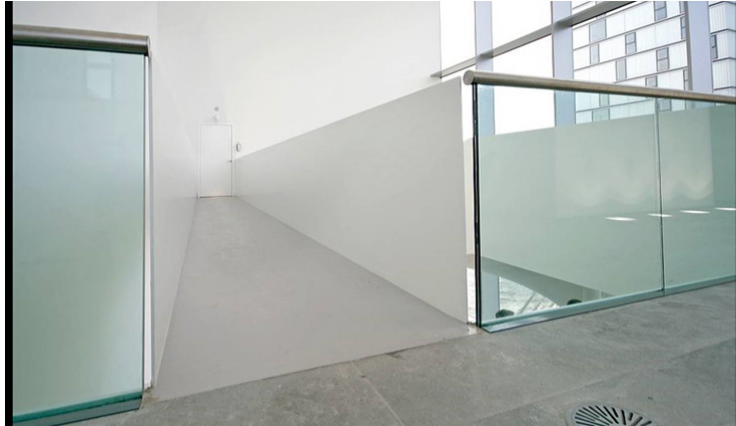
Fig. 5 Glass balustrade Kunstlinie Almere (SANAA/ABT).